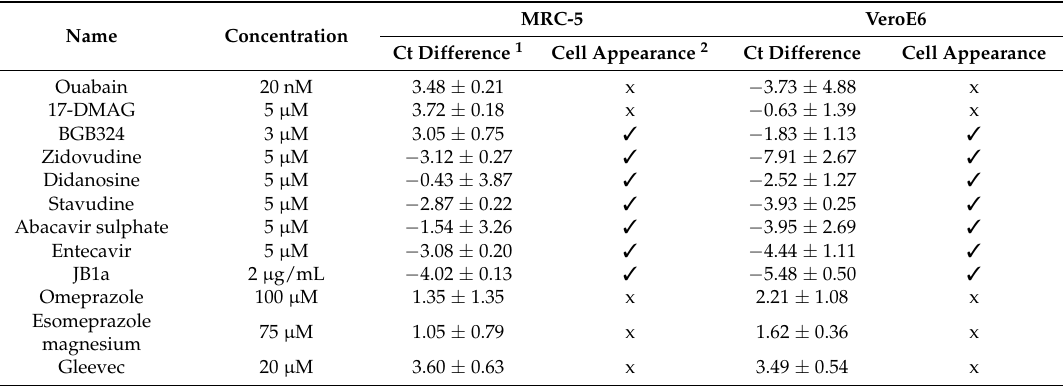
Table 2. Changes in EBOV RNA levels and cell health in MRC-5 and VeroE6 cells treated after infection with compounds at the recommended